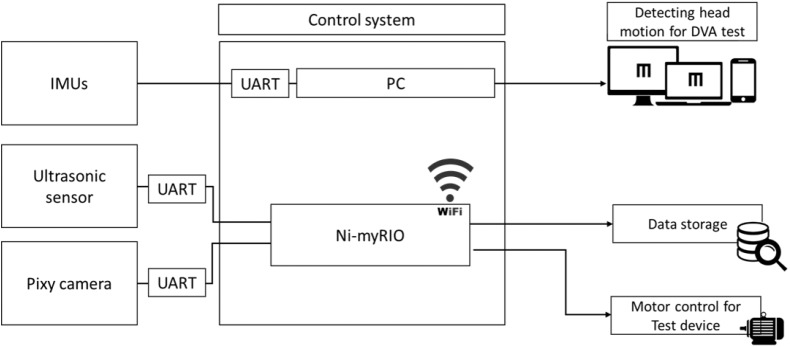
Schematic of the control system. All data from sensors were sent to the control system. Data from the inertial motion unit (IMU) were converted to angular movement and triggered changes in the display. Data from the ultrasonic sensor and video camera module (PIXY) camera were transmitted to the reconfigurable I/O (input/output, myRIO) and translated to trajectory data (cm). DVA, dynamic visual acuity and UART, universal asynchronous receiver/transmitter.